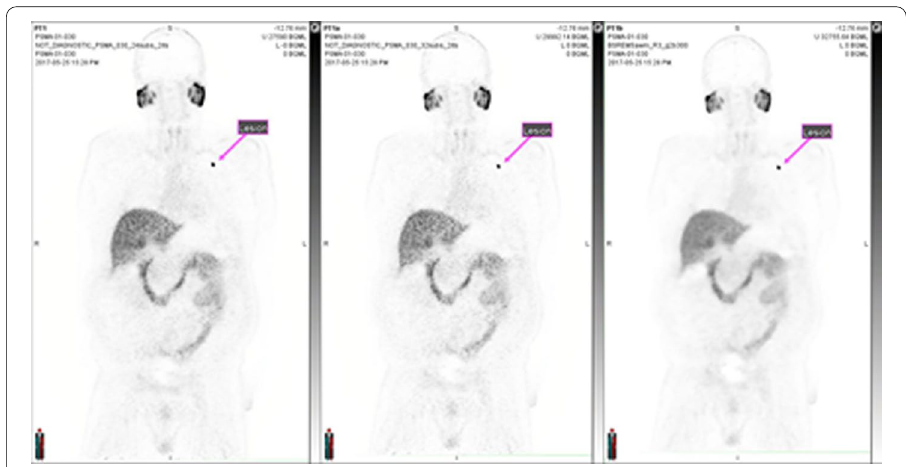
Fig. 11 Reconstruction algorithms applied to patient imaged with PSMA PET. (Left to right) [ 18 F]DCFPyL PET images reconstructed with OSEM (24 subsets, two iterations), OSEM (32 subsets, two iterations), and BSREM (32 subsets, 25 iterations, β =